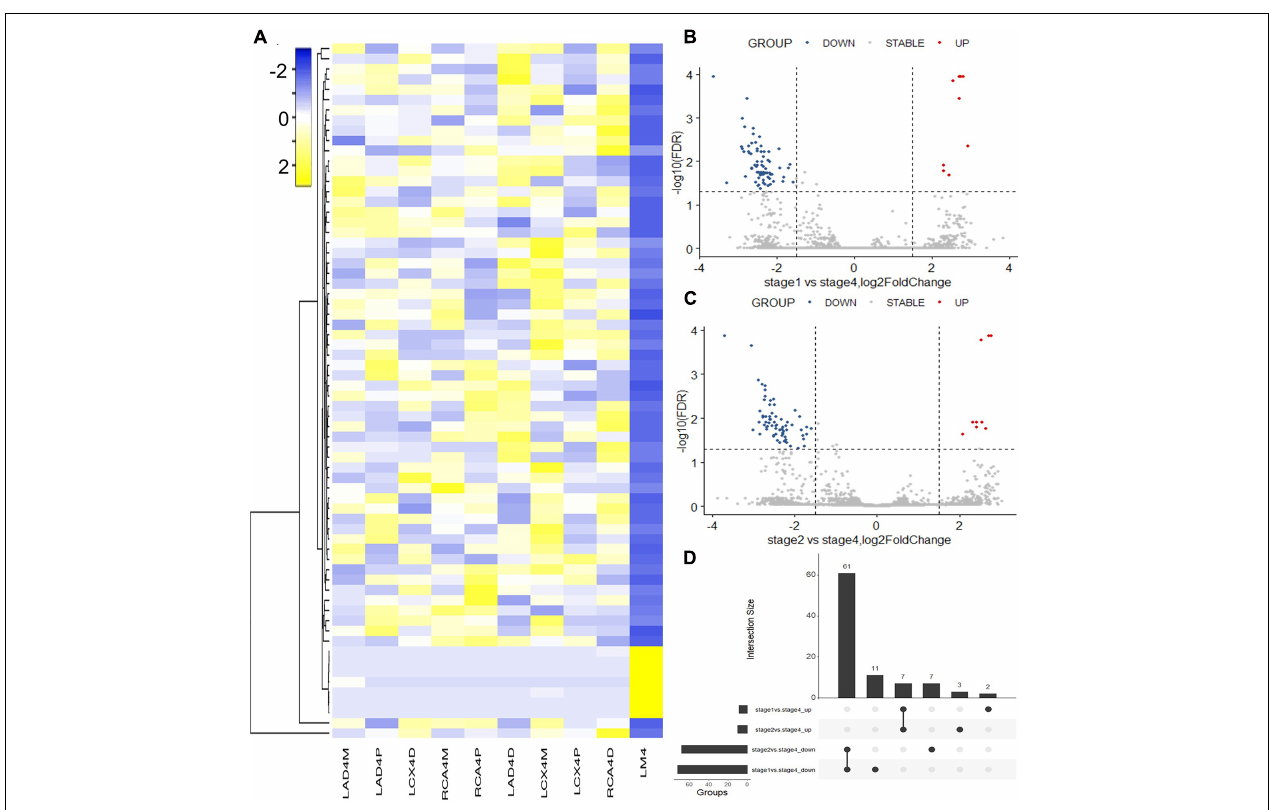
FIGURE 1 | Differentially expressed lncRNAs identified with RNA sequencing. (A) Heatmap of the differentially expressed lncRNAs between coronary artery segments. (B) Volcano map of differentially expressed lncRNAs between stage 1 and stage 4. (C) Volcano map of differentially expressed lncRNAs between stage 2 and stage 4. (D) The intersection of differentially expressed lncRNAs in stages 1 and 2 vs. stage 4. Stage: 0, normal tunica intima; 1, fatty streak tunica intima; 2, fibrous plaques tunica intima; 3, atherosclerotic tunica intima; 4, secondary affection tunica intima.